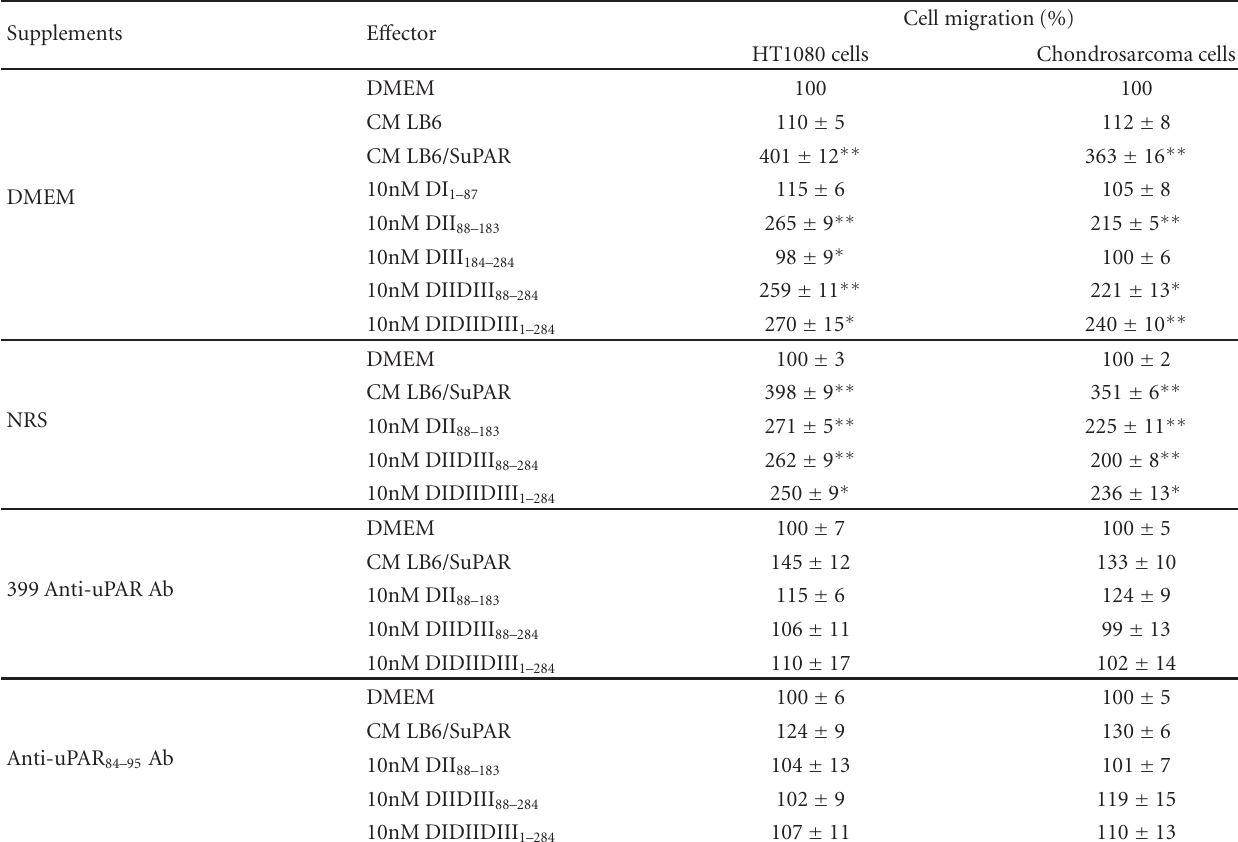
Table 3: SuPAR-dependent migration of chondrosarcoma